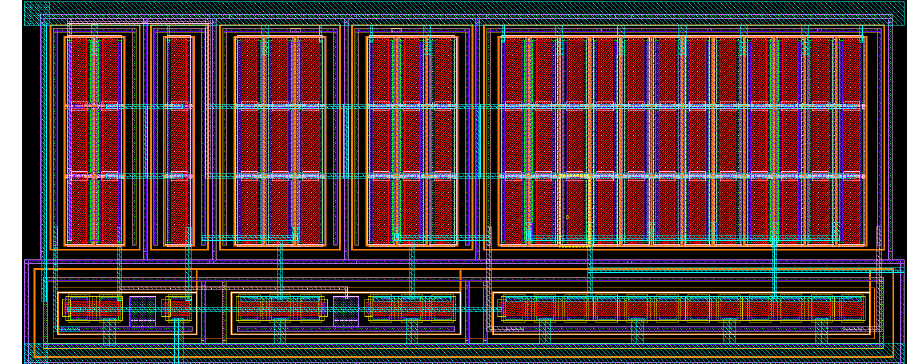
Figure 8. Layout of the proposed OTA: dimensions are 74.84 31.41 µ m. × The simulations were carried out in the Cadence Virtuoso environment. Figure 9 reports the frequency response of the differential gain of the OTA, showing a dc gain of about 41.28 dB, a 7.95 kHz unity-gain frequency and a phase margin around 52°.